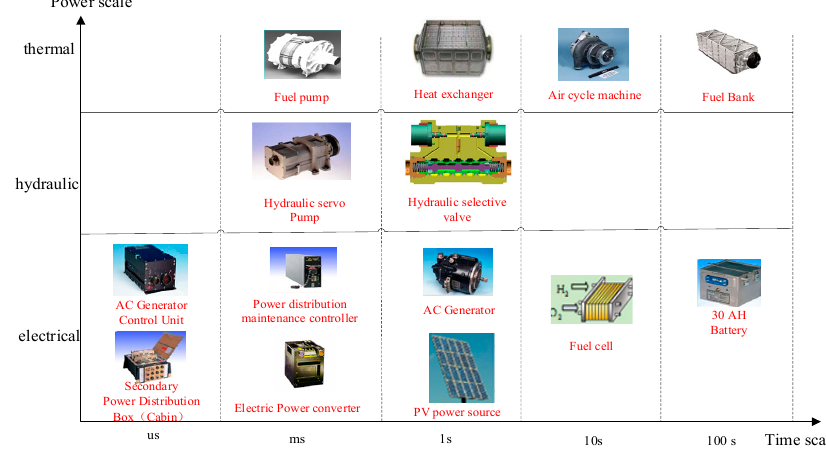
Figure 11. Temporal scale separation of major thermal, hydraulic and electrical system devices in aircraft.